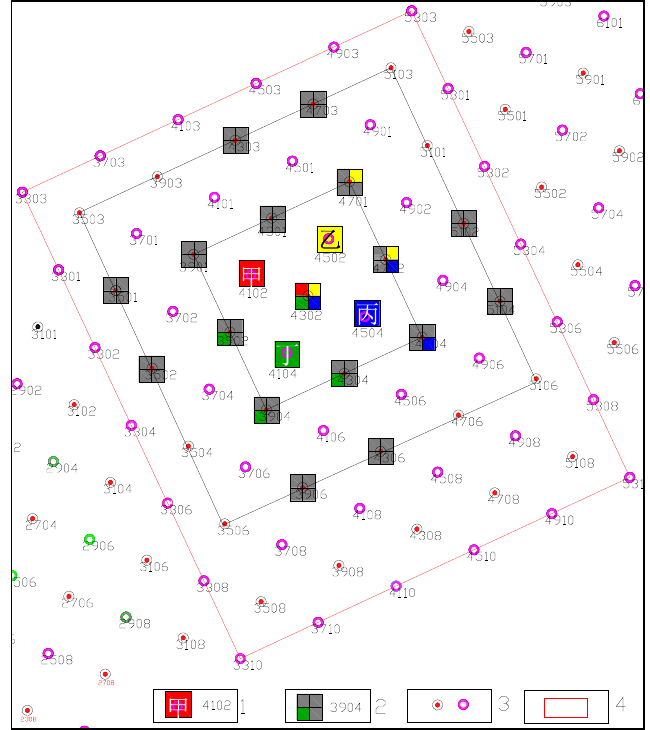
Figure 7. Distribution of polyol tracer and solute monitoring points.